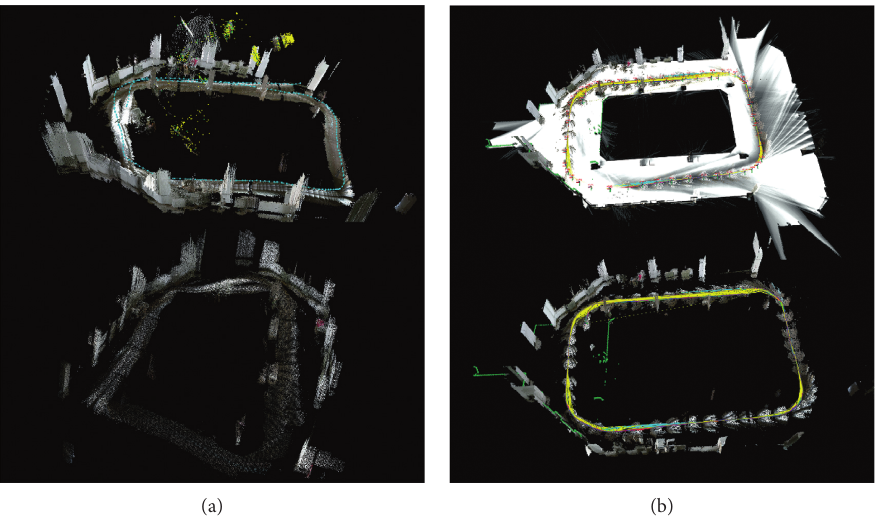
Figure 9: Comparison of mapping results on the second floor. (a) RTAB algorithm result. (b) Our